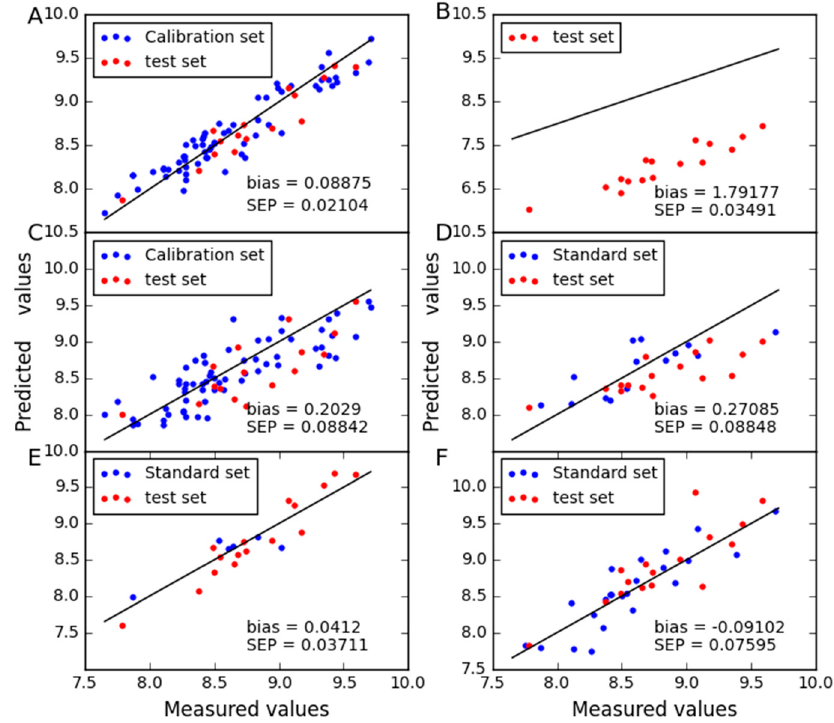
Figure 5. Protein content predicted for corn dataset as determined by ( A ) CTAI, ( B ) MSC, ( C ) TCR, ( D ) CCA, ( E ) SBC and ( F ) PDS. The blue and red dots represent the results for each sample in the train set and test set, respectively.